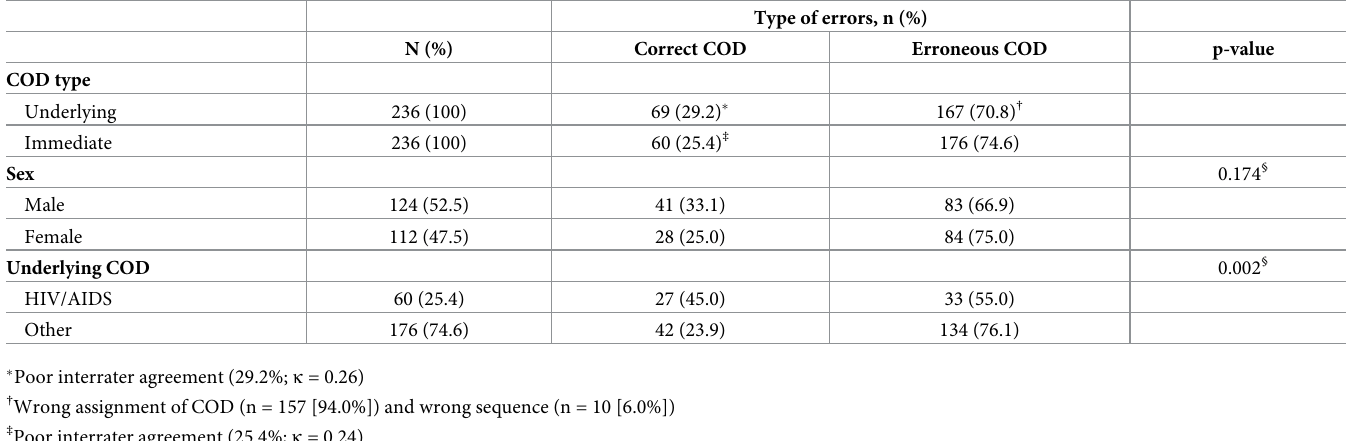
Table 4. Comparison of notified versus the ascertained cause of death (COD) in Kisumu County, Kenya (2019).